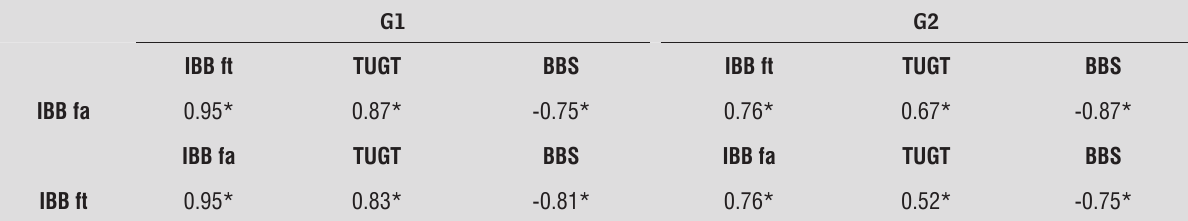
Table 1 - Correlation of IBB with the other